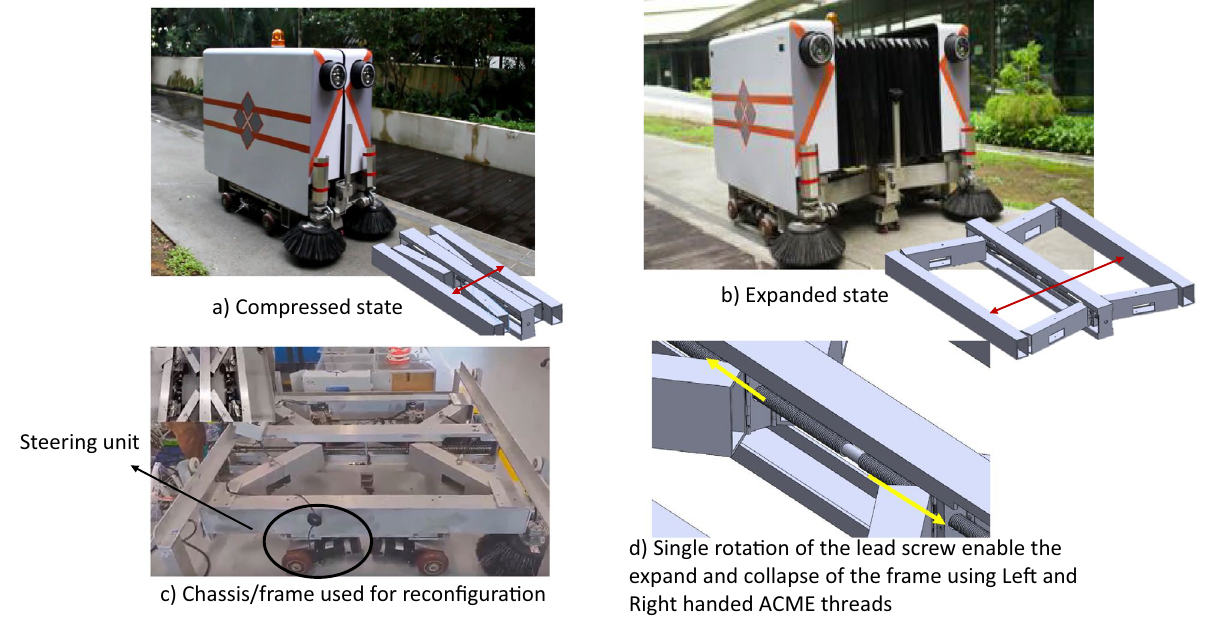
Figure 1. Self-reconfigurable pavement sweeping robot